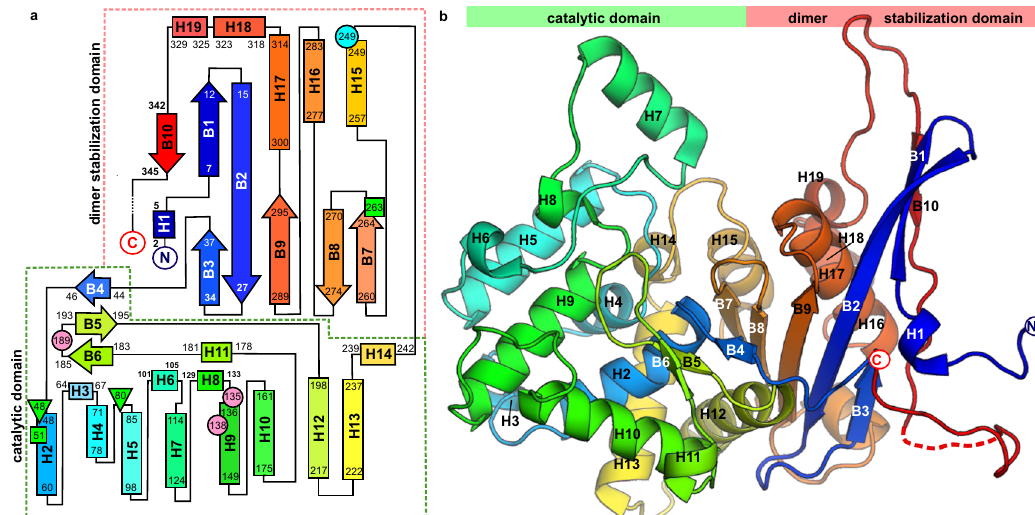
Fig. 1 Topology of the ReAV chain and overall structure of a single subunit. In the topology diagram ( a ), residues involved in zinc coordination (Cys135, Lys138, Cys189) are marked as pink circles, while residues potentially involved in catalysis are marked by green triangles (Ser48, Ser80) and green squares (Lys51, Lys263). Cysteine 249, carrying a posttranslational modi fi cation, is marked by a cyan circle. The overall fold of a single subunit is shown in ( b ).